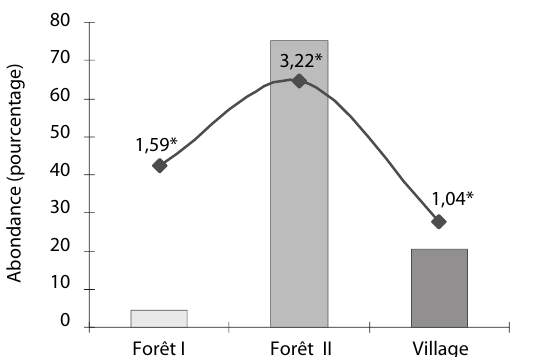
Forêt I Forêt Figure 4. – Abondance et diversité des espèces de tabanidés cap- turées selon le biotope.